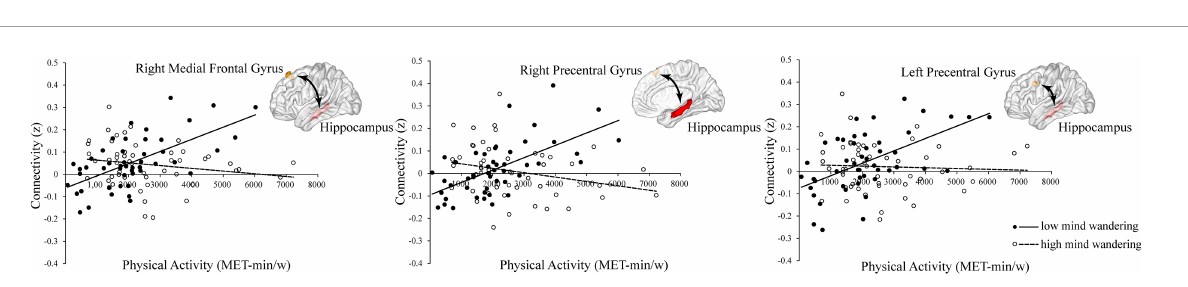
FIGURE3 Positive relations between physical activity and hippocampal functional connectivity at right medial frontal gyrus, right precentral gyrus, and left precentral gyrus in low mind wandering group.